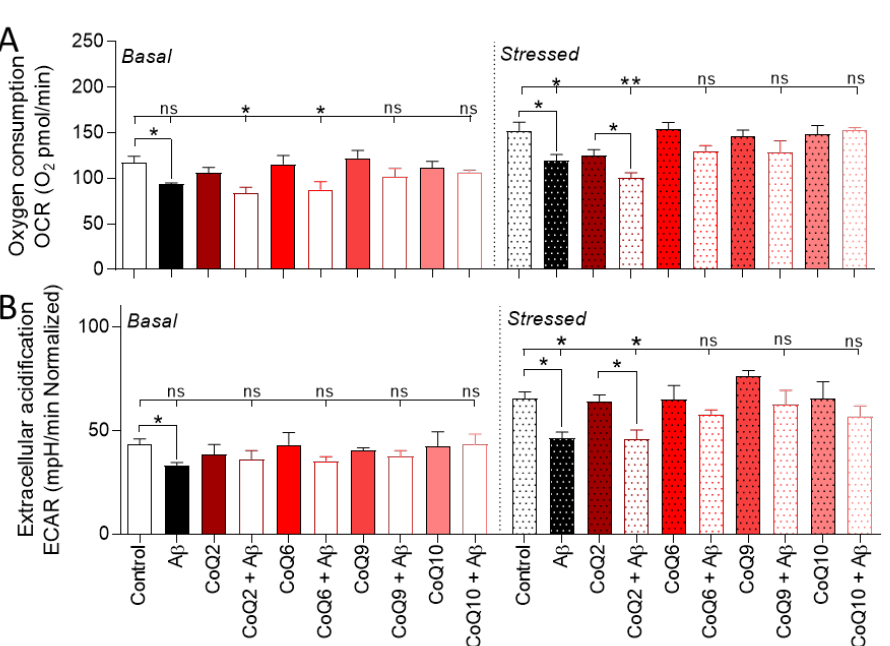
Figure 4. Evaluation of the energetic cellular phenotype in cells exposed to A β 25–35 and different CoQs. bEnd.3 cells were pretreated for 24 h with CoQ2, CoQ6, CoQ9, or CoQ10 and then treated with A β 25–35 for 24 h. ( A ) OCR levels are expressed as oxygen consumption (picomoles) per minute. ( B ) ECAR levels are expressed as changes in pH per minute. Results were normalized against the total number of cells per well. Data are presented as the mean ± SEM. Student’s t -test was used to compare the differences between groups treated with the same ubiquinone and Dunnett’s multiple comparison test to compare each A β 25–35 (plus or minus ubiquinone) treatment with the control. ns: not significant, * p < 0.05, ** p < 0.01 ( n = 3).